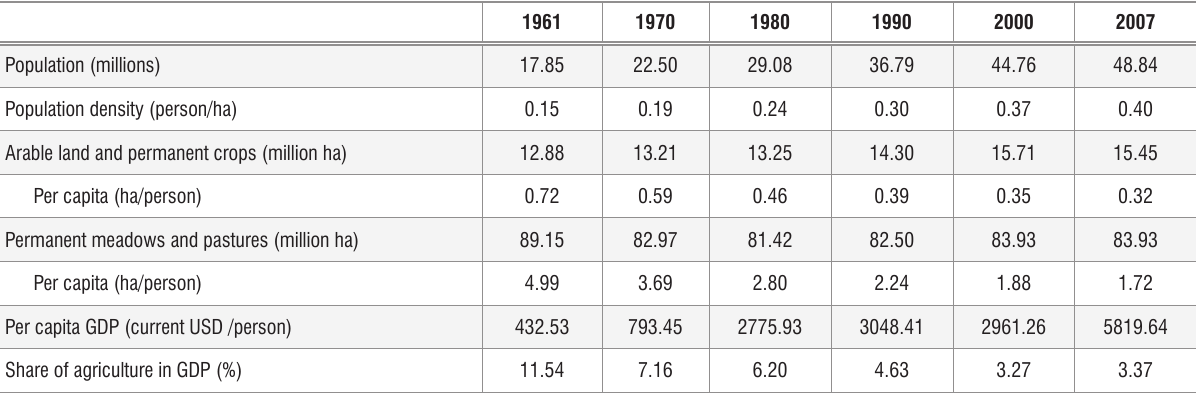
Table 1: Overview of South